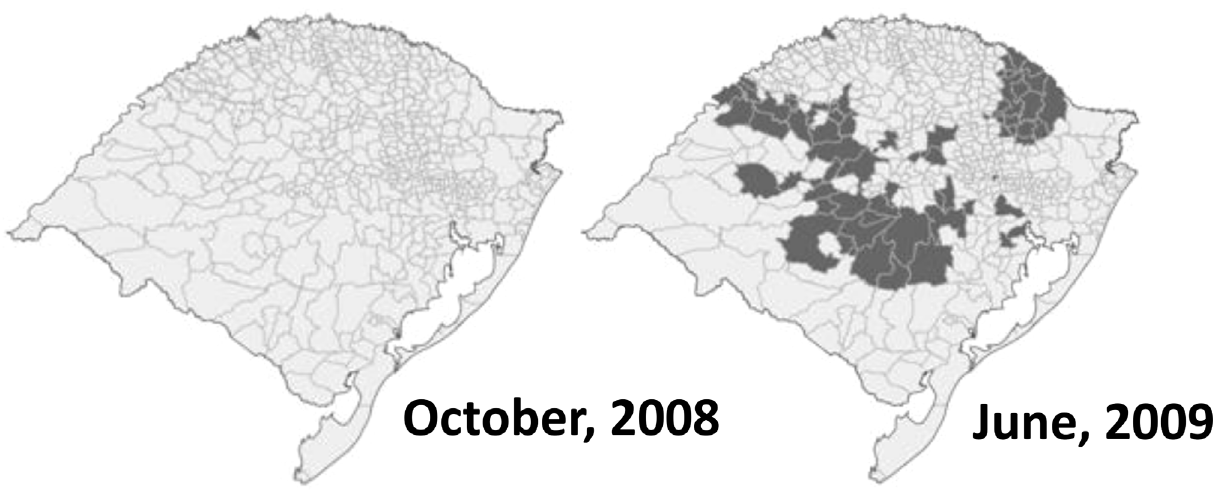
Figure 2. Temporal and geographic spread of yellow fever epizootics involving deaths of non-human primates, Rio Grande do Sul, Brazil, October, 2008 to June, 2009. (Shading corresponds to municipalities with confirmed yellow fever epizootics in non-human primates).